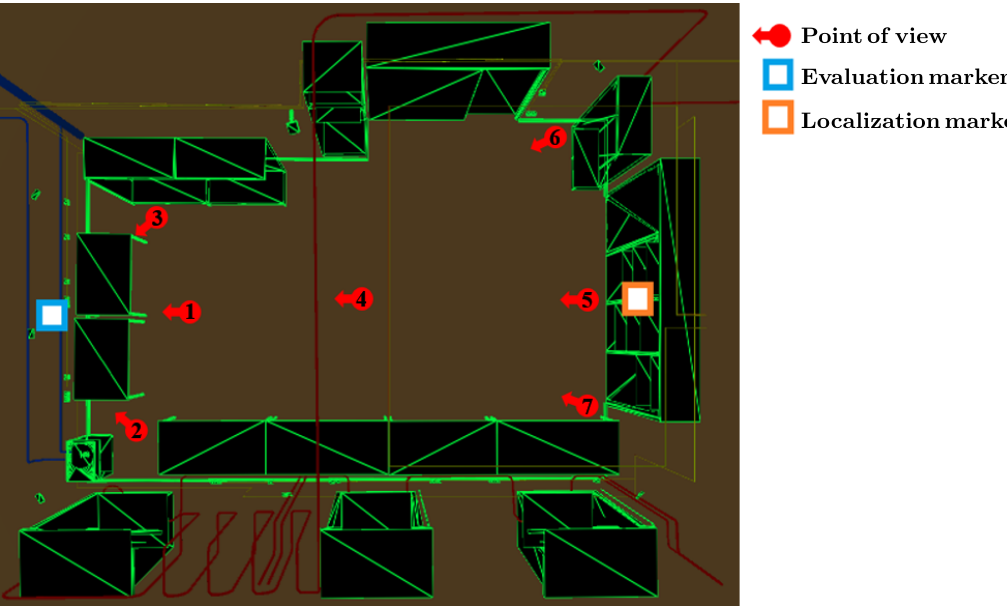
Figure 8. Placement of the seven different points of view that were used during the evaluation in relation to both ArUco